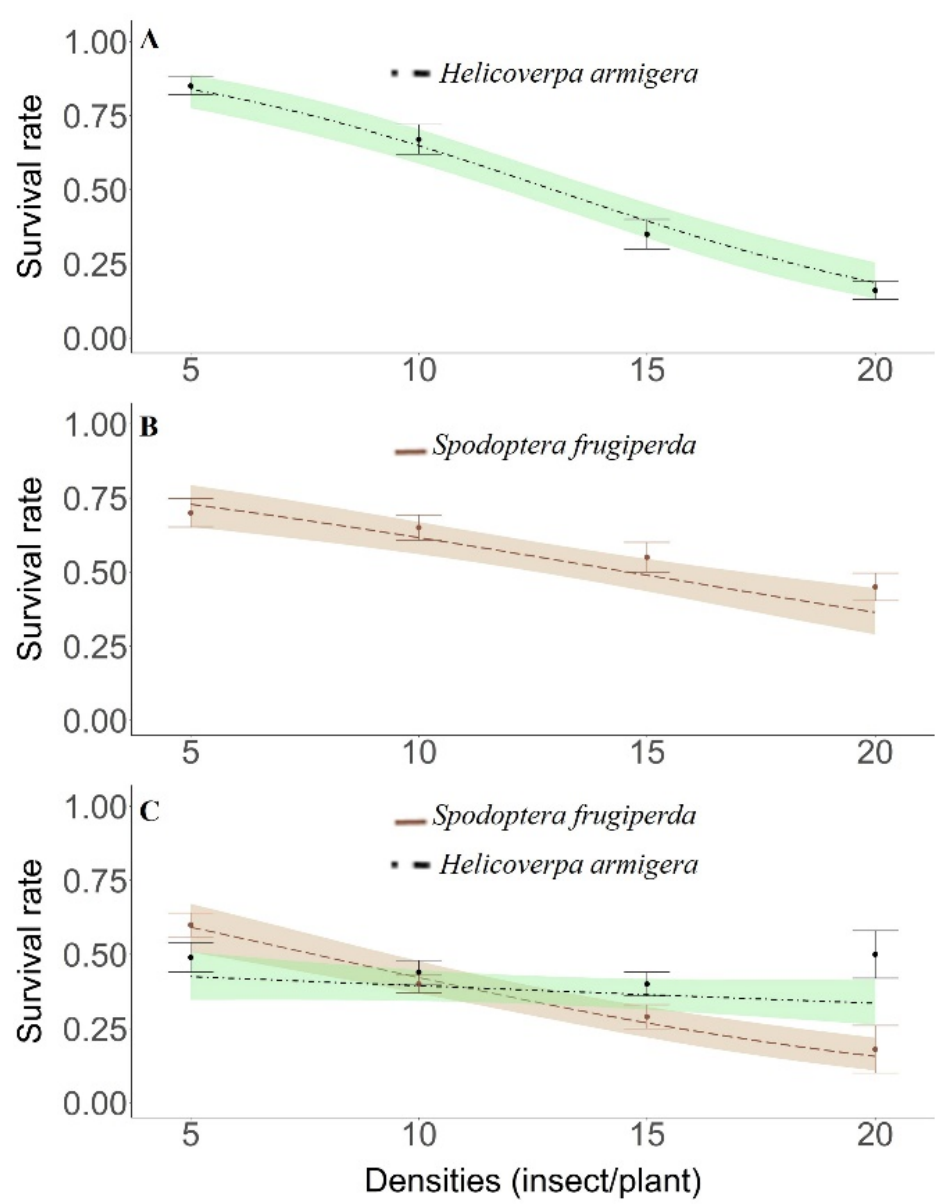
Figure 2. In-field survival rate (mean ± SE) of Spodoptera frugiperda and Helicoverpa armigera larvae isolated (intraspecific competition only) and combined (intra- and interspecific competition). Dashed curve corresponds to the observed data, while the colored areas are the confidence regions (95% CR) predicted by the generalized linear model with binomial distribution. (For a color version of this figure, the reader is referred to the web version of this article.). ( A ) Only H. armigera ; ( B ) Only S. frugiperda ; ( C ) S. Frugiperda + H. armigera . (b) Empty Site : An empty site may become occupied with probability W , due to the insect oviposition in the Moore neighborhood. The probability W was given by the relative fitness ( f 1 and f 2